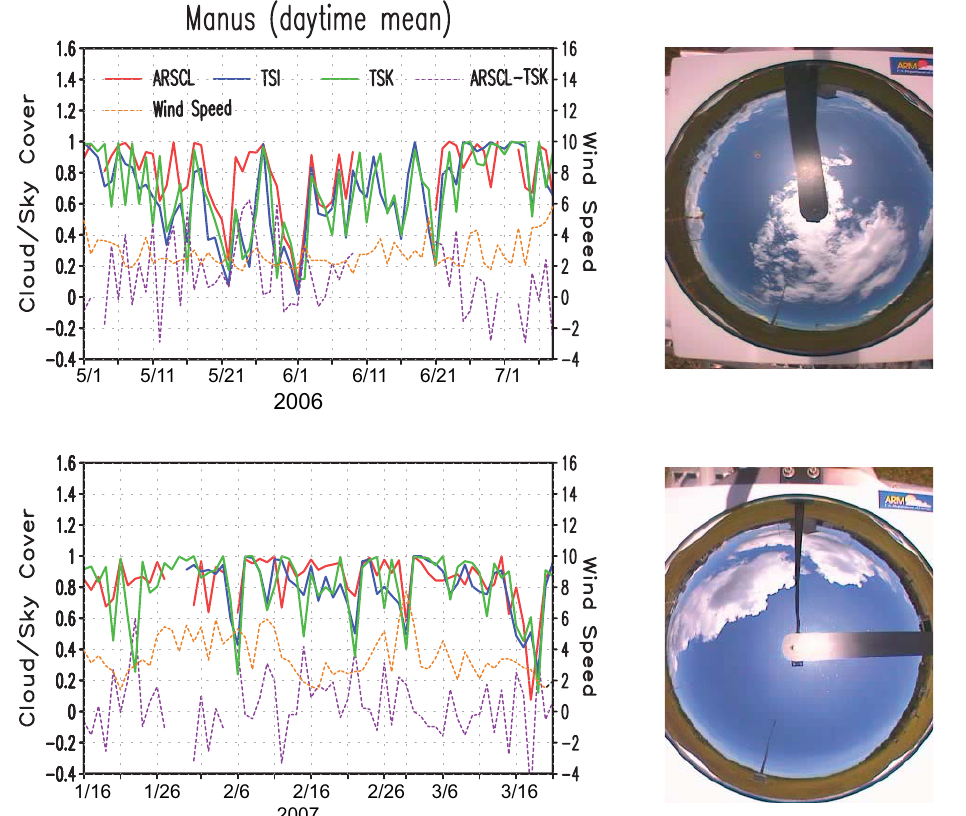
Fig. 1. The time series of daily total sky cover or cloud fraction based on ARSCL, TSI, TSK and ARSCL-TSK over Manus, averaged only for daytime hours for 29 April to 8 July 2006 (top) and 16 January to 26 March 2007 (bottom), respectively, when all three datasets are available and both MPL and MMCR operate normally in ARSCL. Right panels are examples of total sky